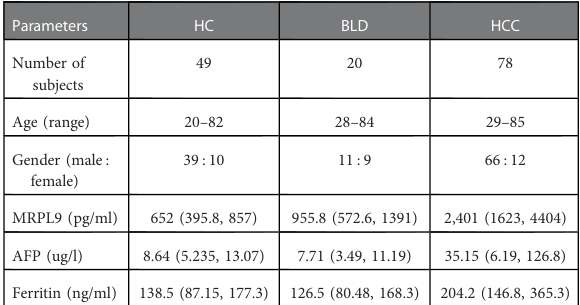
TABLE 1 The factors of enrolled